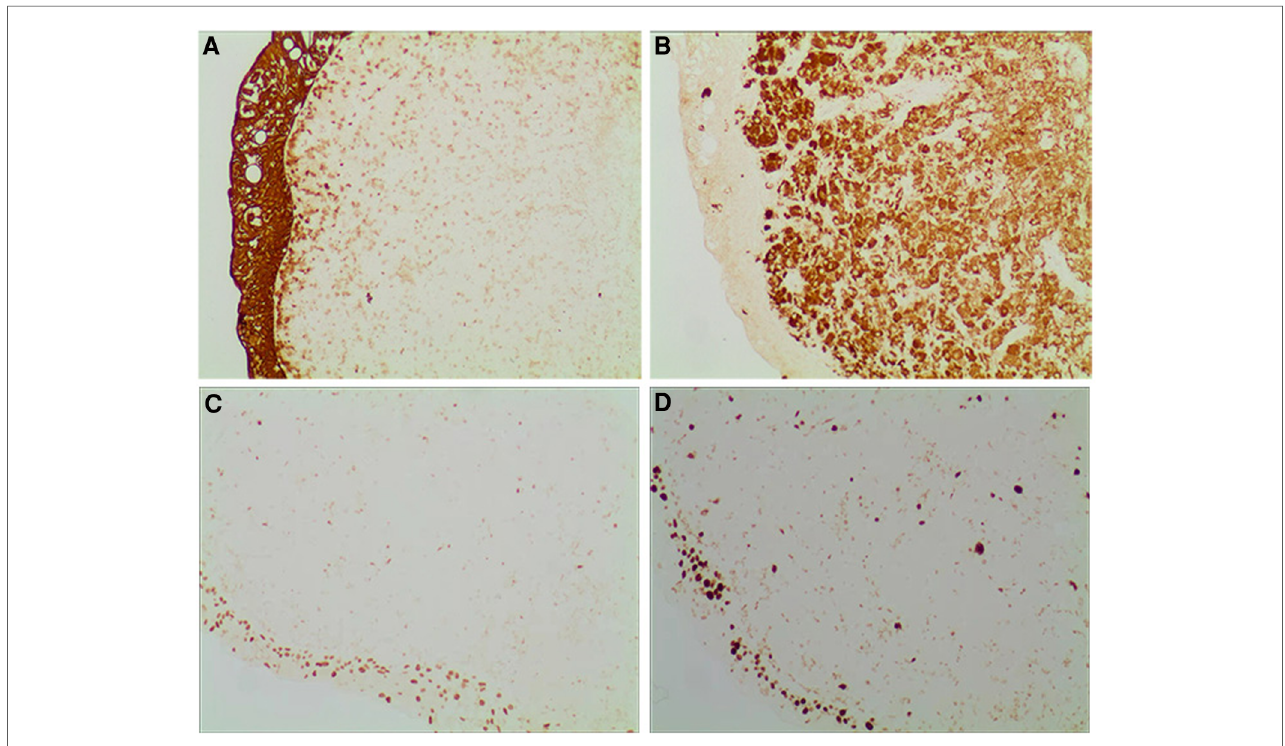
FIGURE 5 Immunohistochemistry (100×) ( A ) keratoconus protein: broad-spectrum cytokeratin was positively expressed in the overlying uroepithelium and negatively in the interstitial cells. ( B ) CD86: CD68 protein was weakly expressed in the overlying uroepithelium and diffusely expressed in the interstitial cells. ( C ) GATA3: GATA3 protein was diffusely expressed in the interstitial cells and weakly expressed in the overlying uroepithelium. ( D ) Ki-67: Ki-67 protein was diffusely expressed in the interstitial cells and weakly expressed in the overlying uroepithelium.